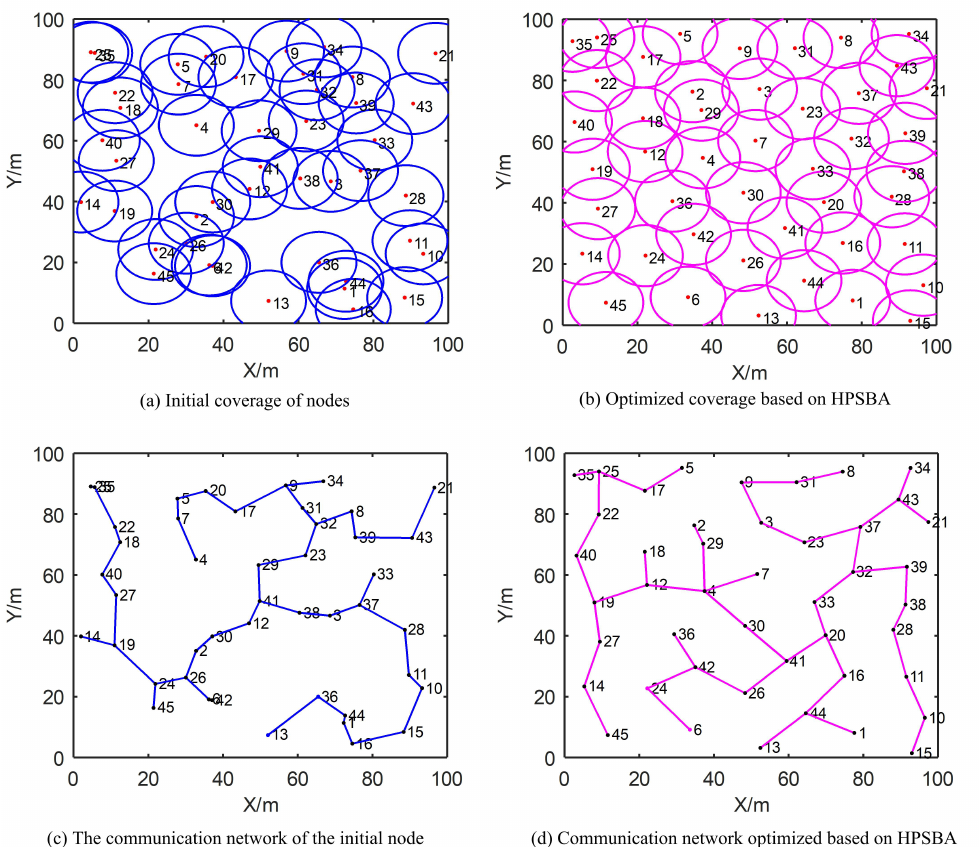
Figure 10. Node coverage and communication distribution